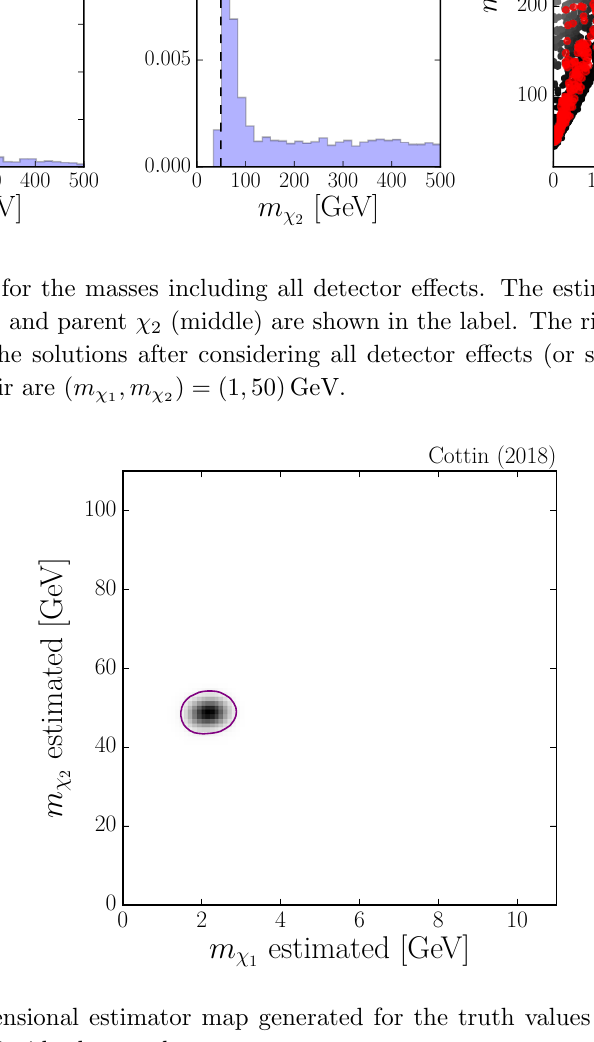
) = (1 ; 50). ; m (cid:31) 1 2